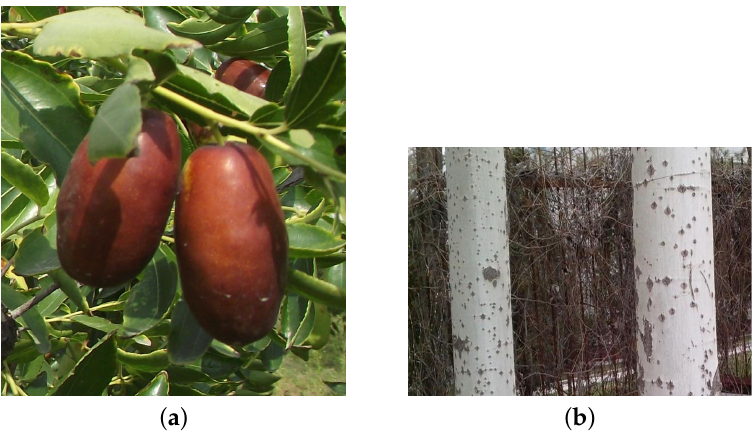
Figure 2. Original images. ( a ) Mature long jujube. ( b )